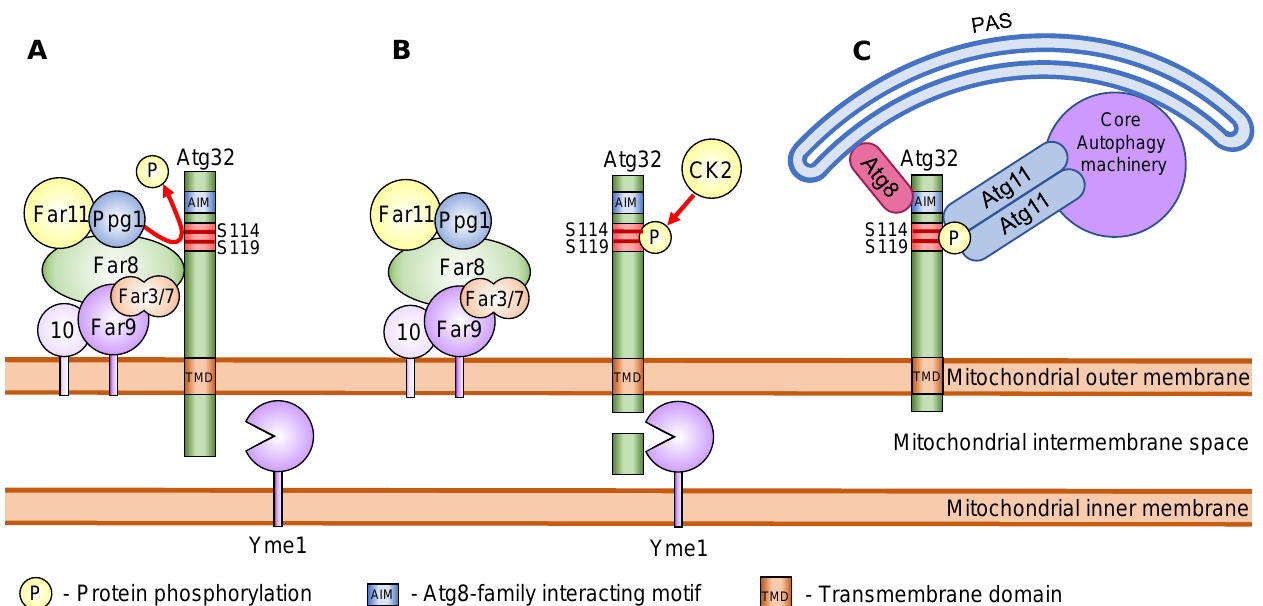
Figure 2. Schematic model of the regulation of Atg32 phosphorylation. ( A ) In the absence of mitophagy stimuli, phosphory- lation of Atg32 is prevented by the Far complex and Ppg1. ( B ) Mitophagy stimuli lead to the dissociation of the Far complex from Atg32 and allow CK2 to phosphorylate Atg32 at Ser114 and Ser119. Mitophagy stimuli also lead to the proteolytic cleavage of the Atg32 C-terminal region by the i-AAA protease complex Yme1. ( C ) The phosphorylated Atg32 interacts with Atg11. Atg11 recruits the mitochondria to the PAS, where the core autophagy machineries initiate isolation membrane formation. Atg32 also interacts with the isolation membrane, localizing Atg8 via the AIM sequence and facilitating the extension of the isolation membrane along the surface of the